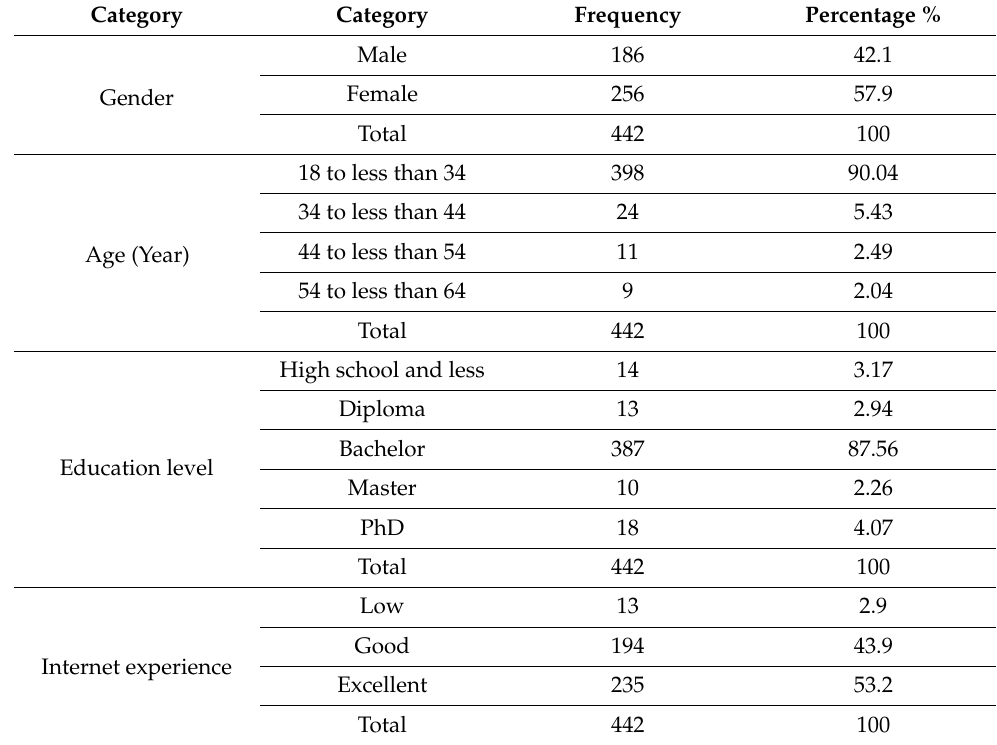
Table 1. Description of the respondents’ demographic